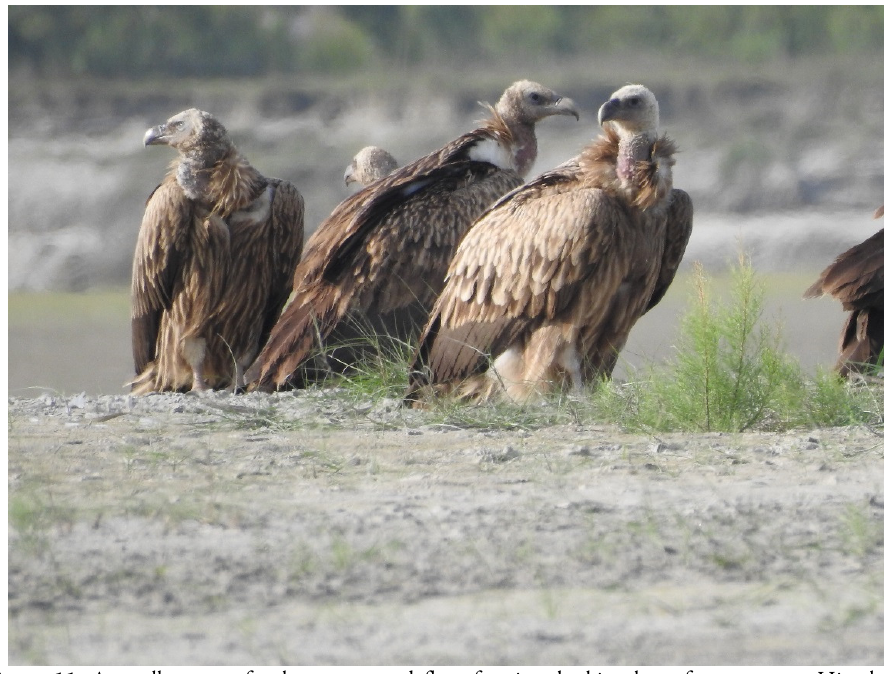
Figure 11. A small group of vultures on mud flat of a river basking late afternoon sun. Himalayan Griffon Gyps himalayensis vulture is a Near Threatened and migratory